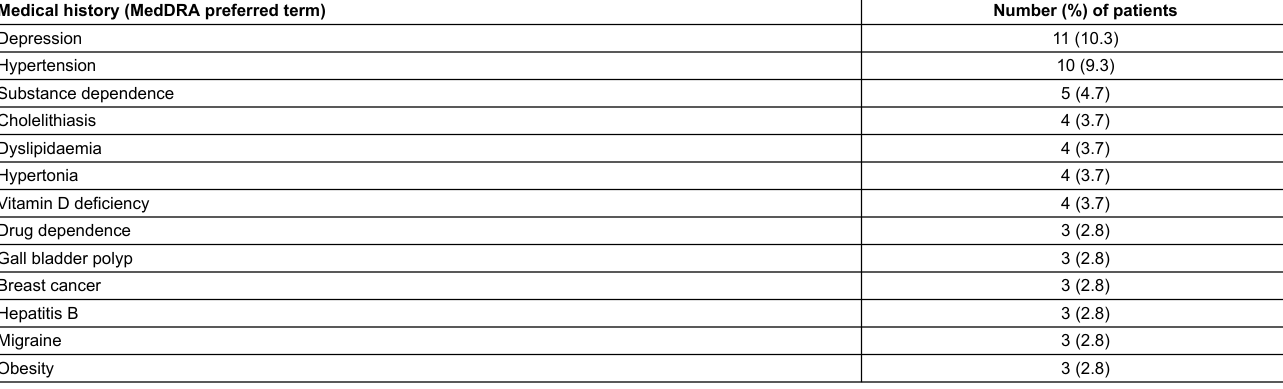
Table S5: Most frequently reported medical histories (≥2% of patients) (safety population, N = 107). Medical history (MedDRA preferred term)